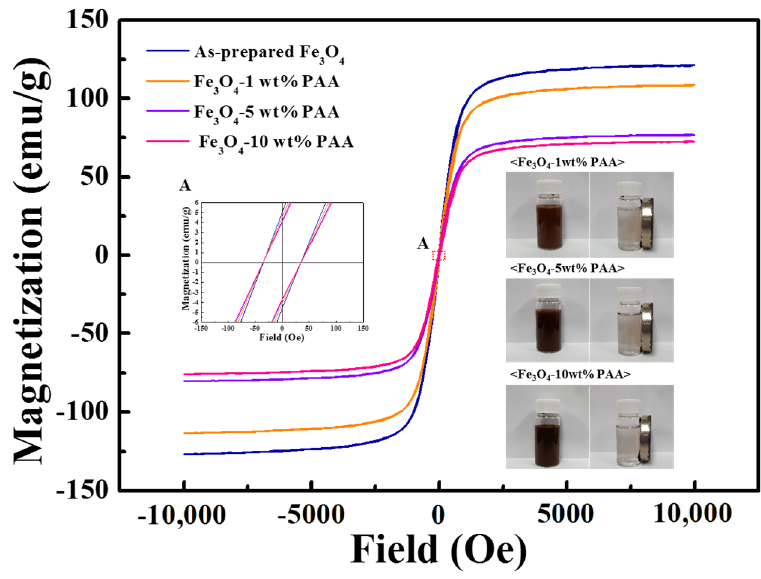
Figure 7. Magnetization curves of as ‐ prepared Fe 3 O 4 and Fe 3 O 4 −